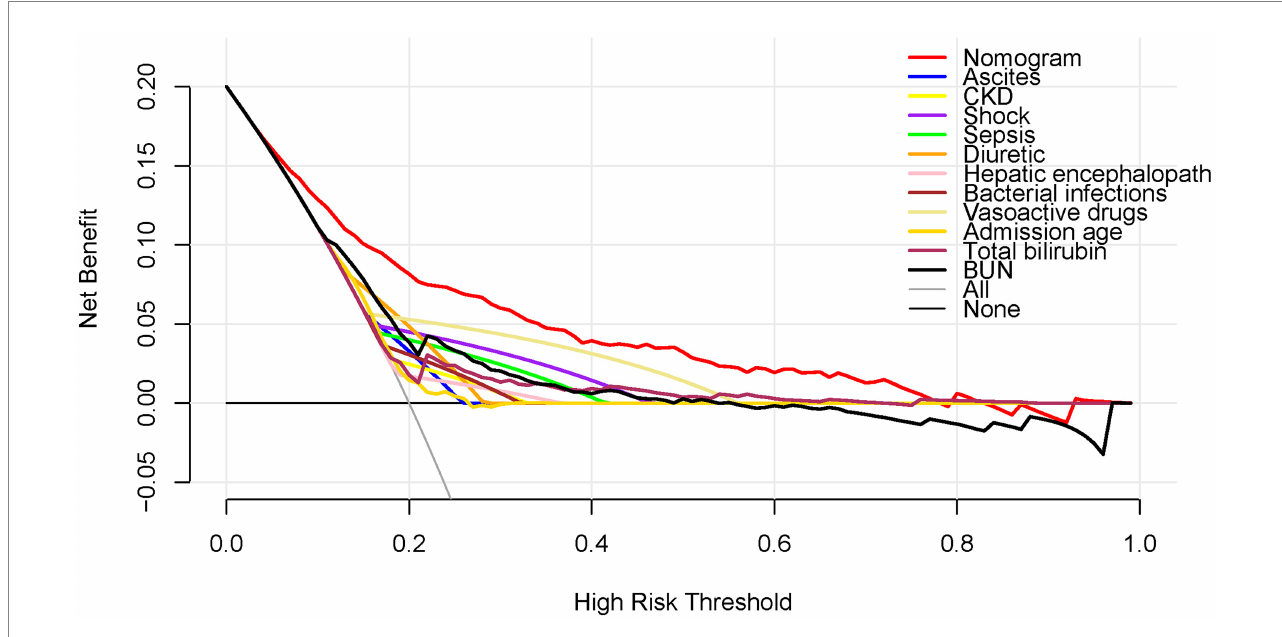
FIGURE 4 DCA of the